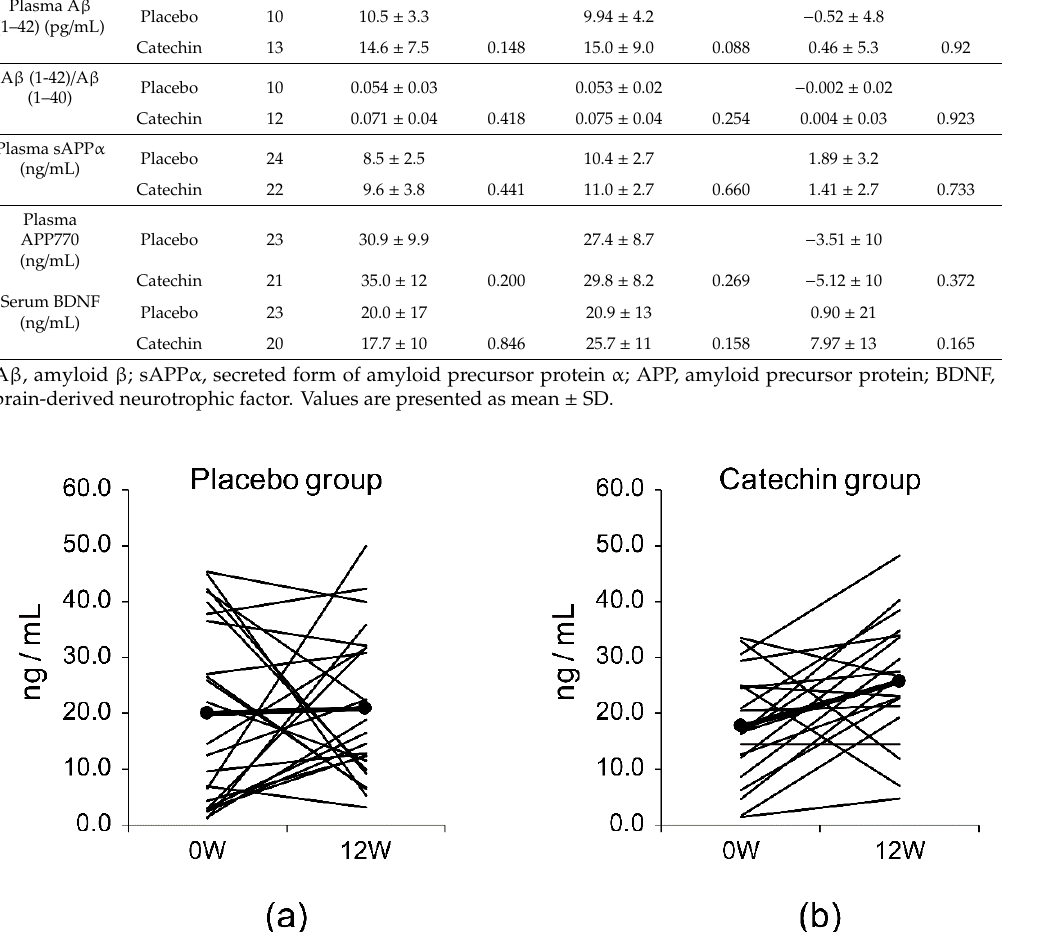
Table 8. Effects of green tea catechins on dementia-related blood biomarkers. Table 8. E ff ects of green tea catechins on dementia-related blood biomarkers. − 1 Week p n (Baseline) Values